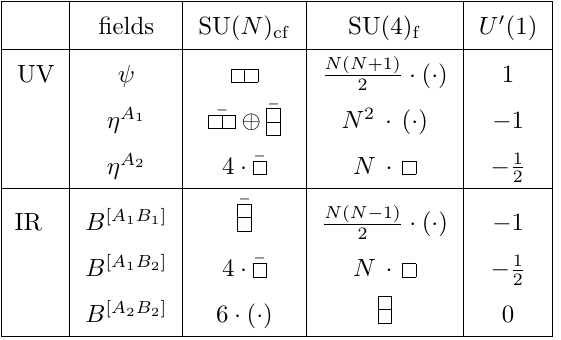
Table 2 . Color-flavor locked phase in the ψη model. A 1 or B 1 stand for the first N flavors ( A 1 , B 1 = 1 , 2 , . . . , N ), whereas A 2 or B 2 run over the rest of the flavor indices, N +1 , . . . , N +4 . The set of potentially massless baryons B [ A 2 B 2 ] , which were not explicitly taken into account in [10, 25], do not contribute to SU( N ) cf × SU(4) f × U 0 (1) anomalies. fields SU( N ) c